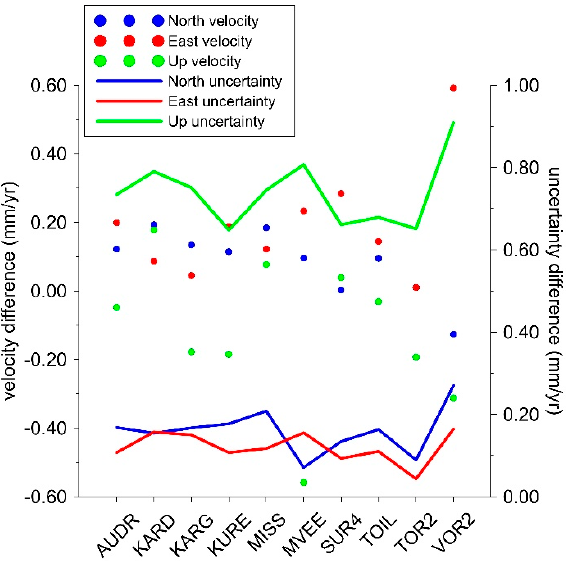
Figure 12. Differences between velocities and their uncertainties of GOA_2 solution (using FN + WN model for N and E, and GGM model for U) and GOA time-series’ MIDAS solution.